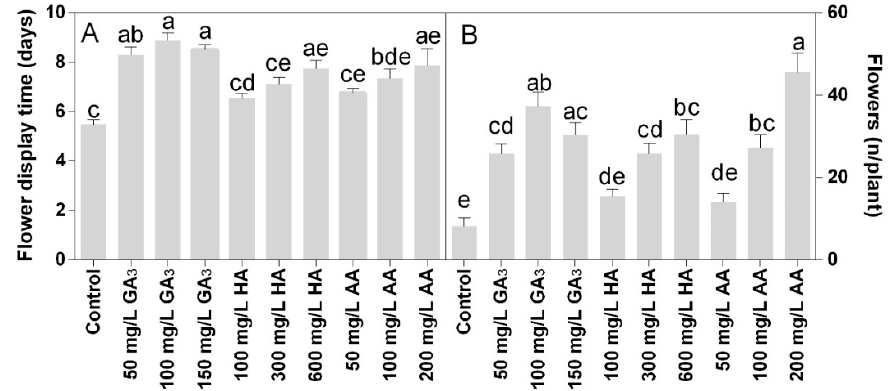
Figure 5. Effect of gibberellic acid (50–100–150 mg L − 1 GA 3 ), humic acid (100–300–600 mg L − 1 HA), and